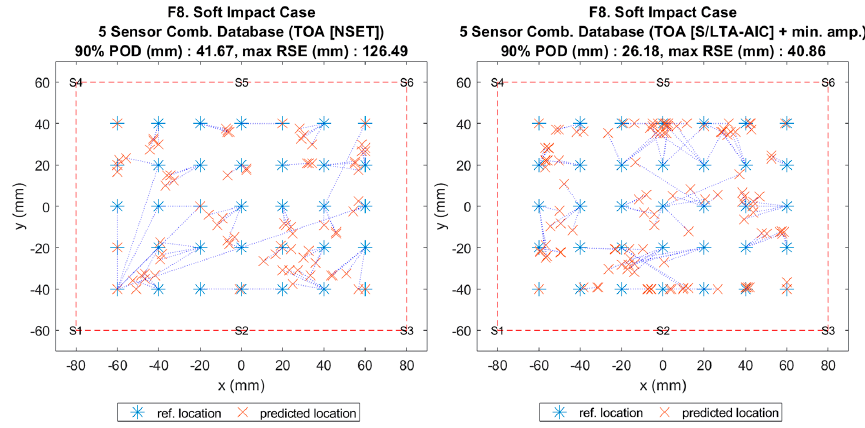
Figure 11. Visualisation of impact localisation for soft impacts (F8) using different methods: ANN (left) and reference database (right).